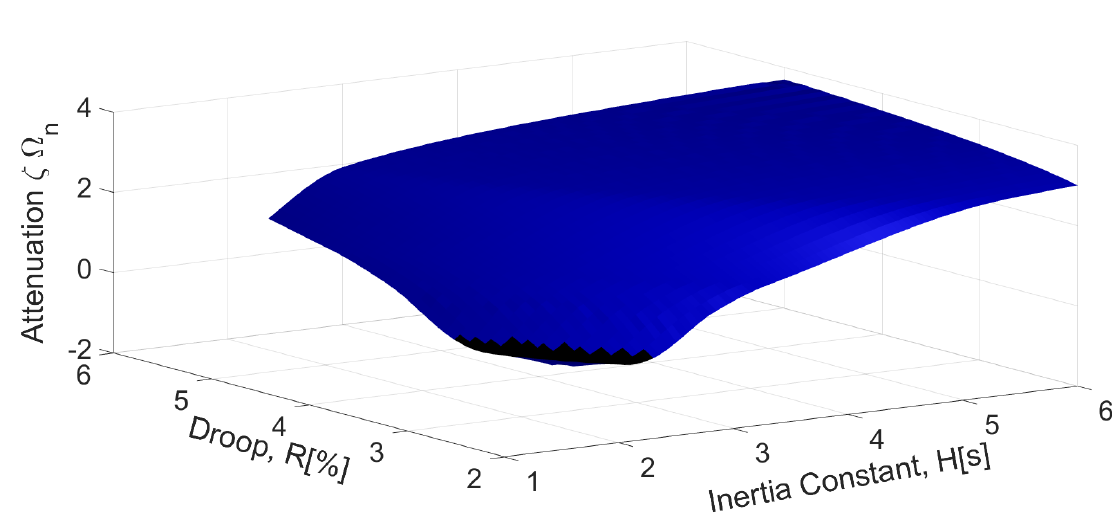
Figure 11. Impacts of R and H on attenuation for Wind Turbine.